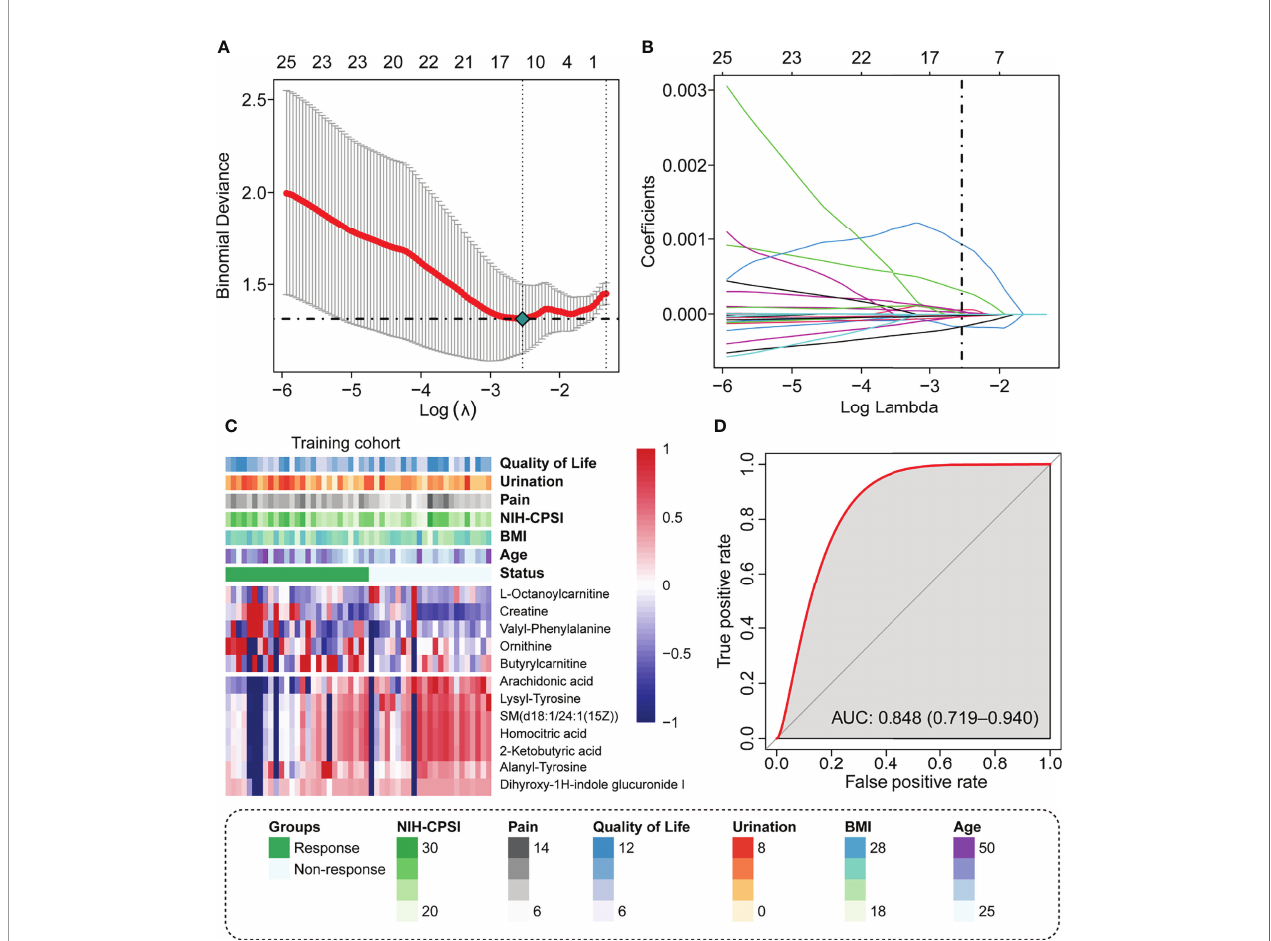
FIGURE 1 | Identify the predicted metabolite response to the LiST treatment response. (A) The optimal tuning parameter (lambda) in the LASSO analysis selected with 10-fold cross-validation and one standard error rule; (B) LASSO coef fi cient pro fi les of the 25 metabolites; (C) Heatmap showing the distribution of 12 selected prediction metabolites and clinical features in the training cohort; (D) Prediction value of metabolism score assessed by the ROC